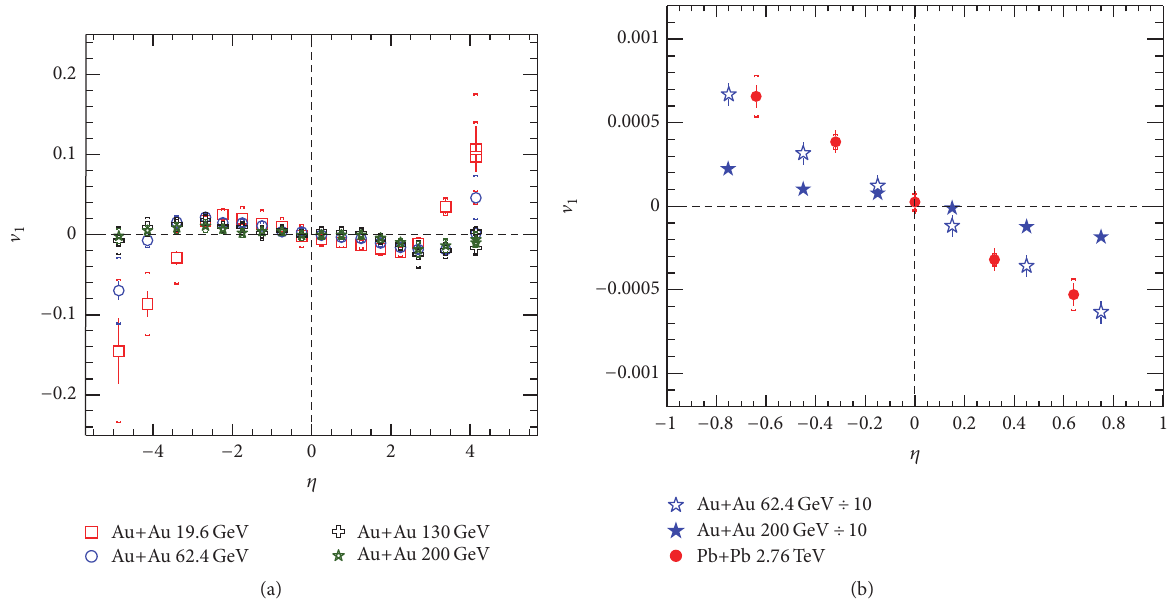
Figure 2: (a) Charged particle V 1 as a function of 𝜂 for 0–40% central Au+Au collisions at √𝑠 NN = 19.6 , 62.4, 130, and 200 GeV, measured by PHOBOS at RHIC [42]. (b) Comparison of charged particle V 1 versus 𝜂 at RHIC [44] and LHC [53] energies. Note that all the RHIC data points are divided by 10 in order to be plotted on a common scale with LHC results.